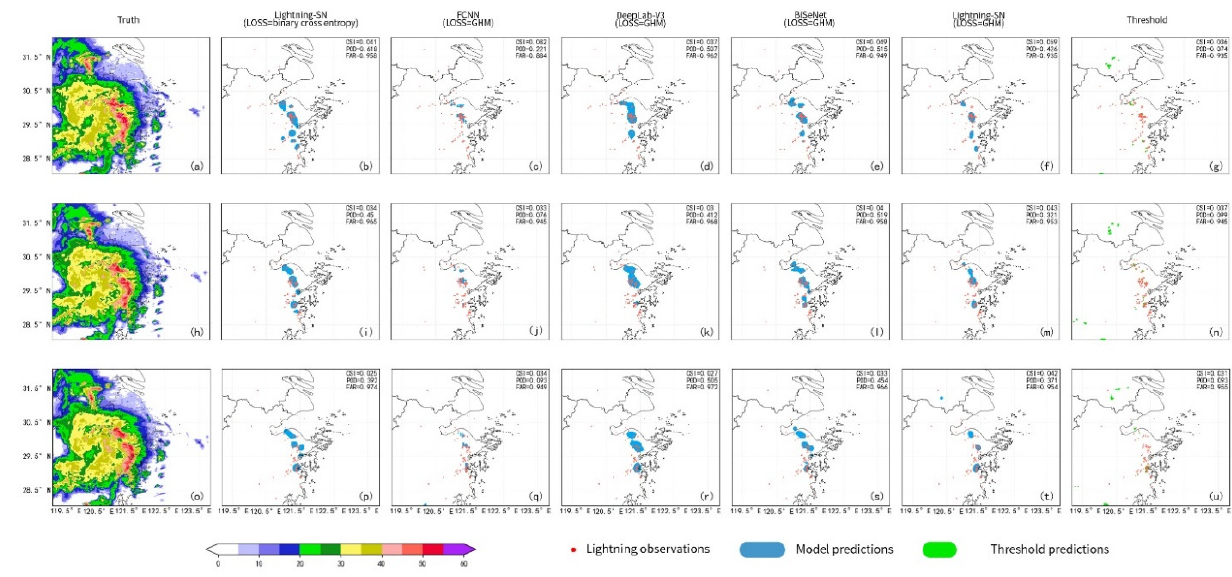
Figure 7. Similar to Figure 6, but for lightning identification from 23:36 to 23:54 on 14 May 2021. ( a –